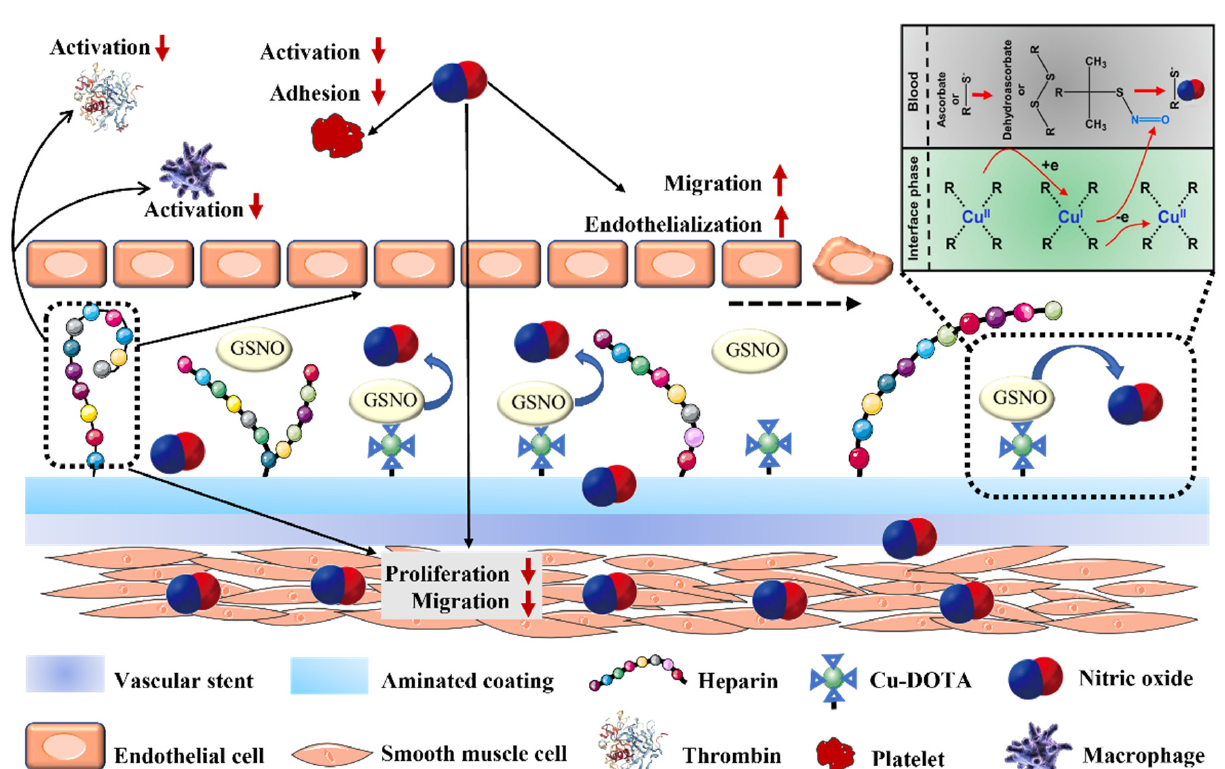
Figure 4. Schematic diagram of the durable endothelium-mimicking coating on stents. The coating is developed by covalently immobilizing Cu–DOTA coordination complexes (NO-producing sub- stances) and heparin. By combining NO and heparin, the coating inhibits thrombogenic responses and the proliferation of VSMCs, thereby reducing the risk of thrombosis and stenosis of the stent. Upward arrows in red represent enhancement, and downward arrows in red represent inhibition.